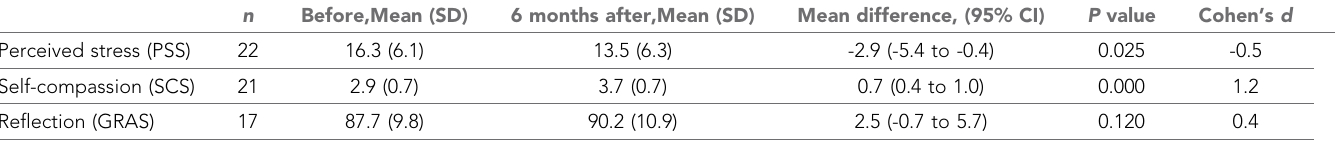
Table 3. . Differences in perceived stress, reflection and self-compassion between ’before’ and ’6 months after’ the mindfulness training